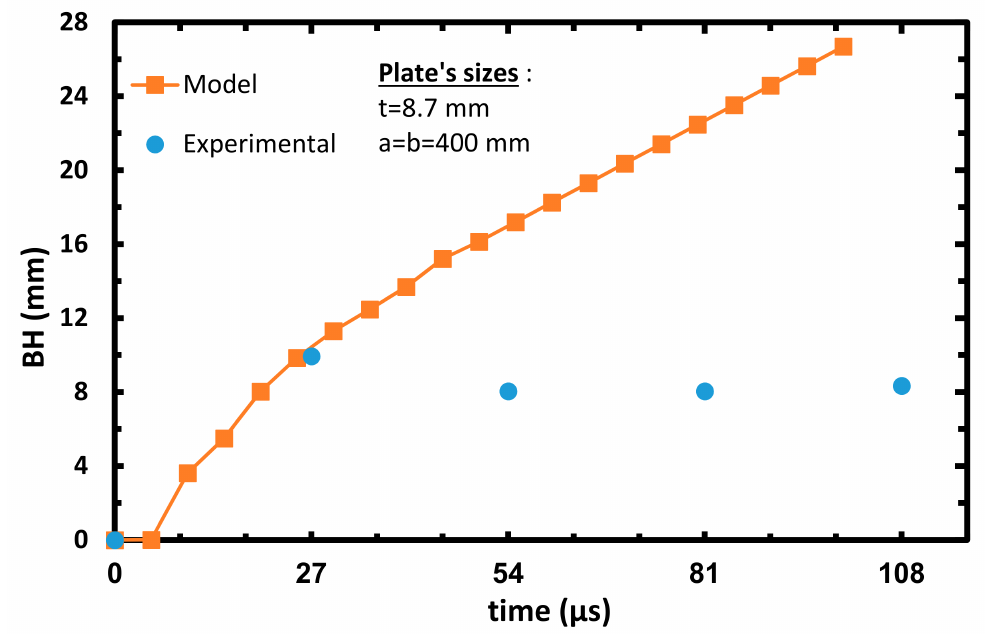
Figure 19. Plate’s bulge height vs. the time of the calibrated model, Vinitial = 814